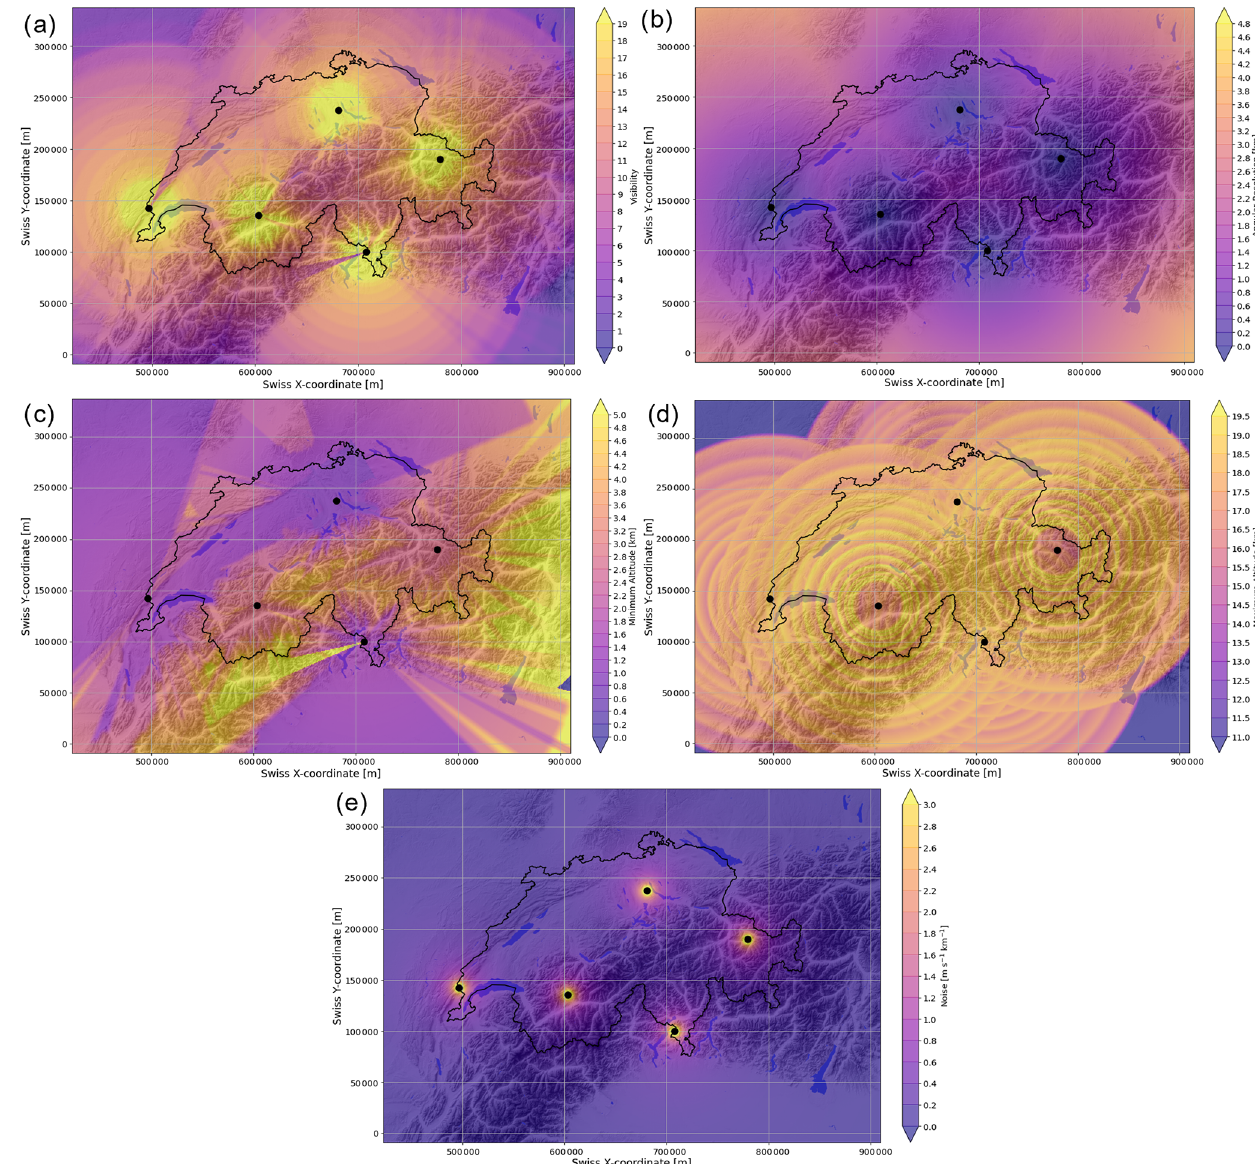
Figure C1. Components contributing to the relative quality index for mesocyclone detection in the Swiss radar network: (a) vertical sum of visibility, (b) azimuthal resolution, (c) minimum altitude of observations, (d) maximum altitude of observations and (e) numerical noise in the azimuthal-velocity